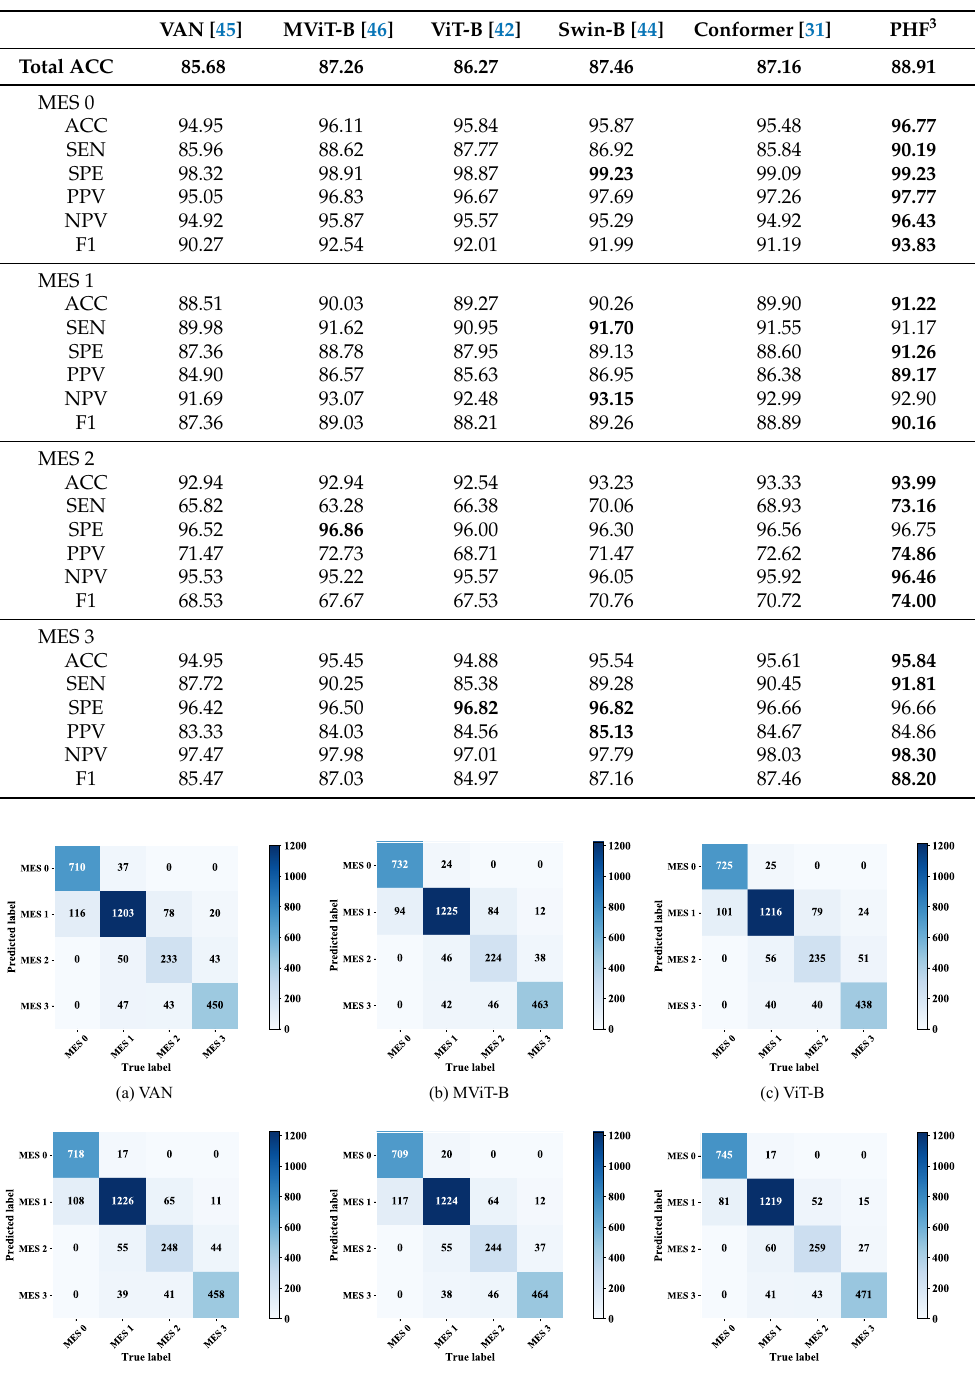
Table 6. Comparison of the proposed PHF 3 with some advanced Transformer models.